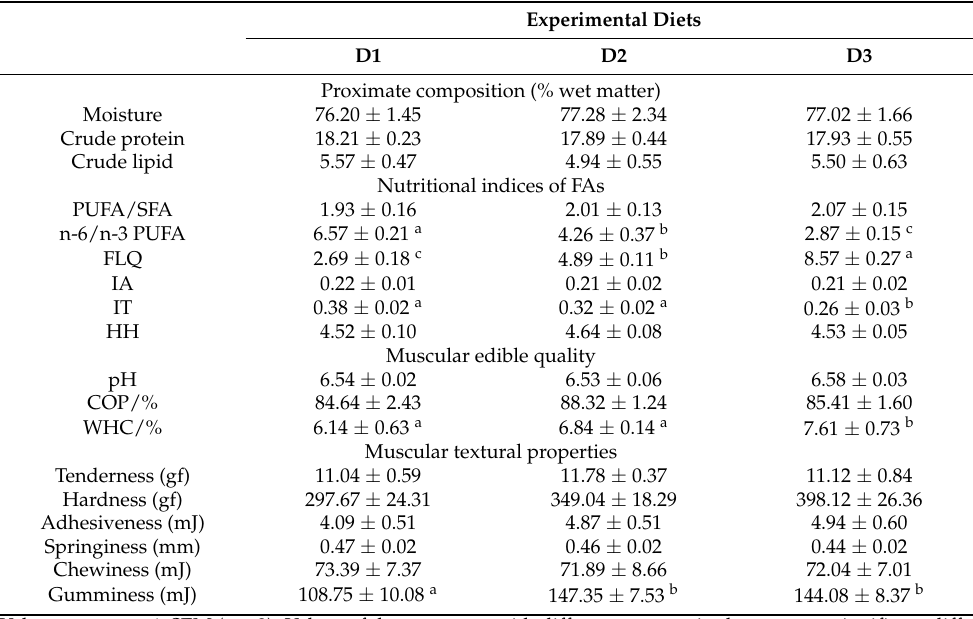
Table 5. The resulting muscle proximate compositions, edible quality, and textural